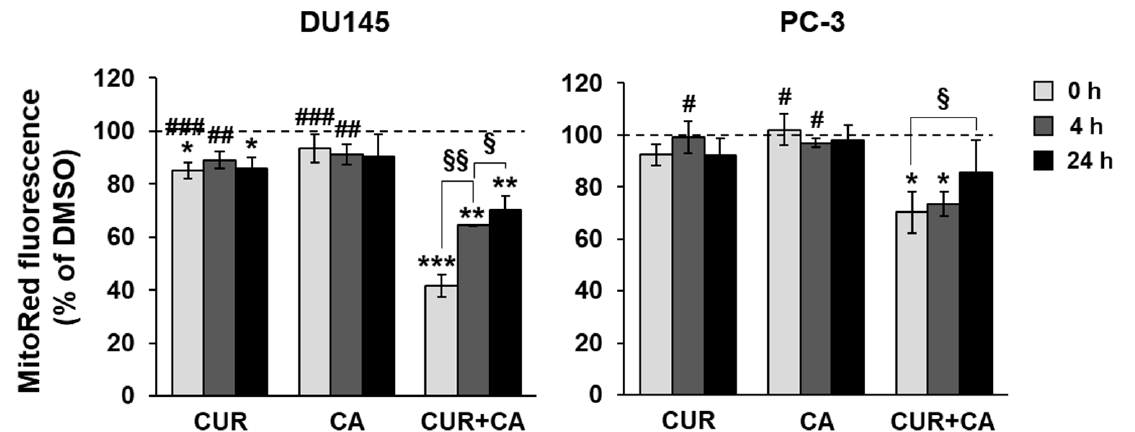
Figure 6. Combinatory effects of curcumin and carnosic acid on the mitochondrial membrane potential. Cells were treated with 7 µ M CUR and 5 µ M CA, alone and in combination (CUR + CA). The data were recorded at 5 min (0 h), 4 h and 24 h after the addition of DMSO or polyphenols. Data are presented as mean ± SEM ( n = 3) relative to DMSO-treated cells. Statistically significant differences for CUR, CA or CUR + CA vs. DMSO (* p < 0.05; ** p < 0.01 and *** p < 0.001) and for CUR and CA vs. CUR + CA (# p < 0.05; ## p < 0.01 and ### p < 0.001). § p < 0.05 and §§ p < 0.01, significant difference between the indicated groups (Student’s t